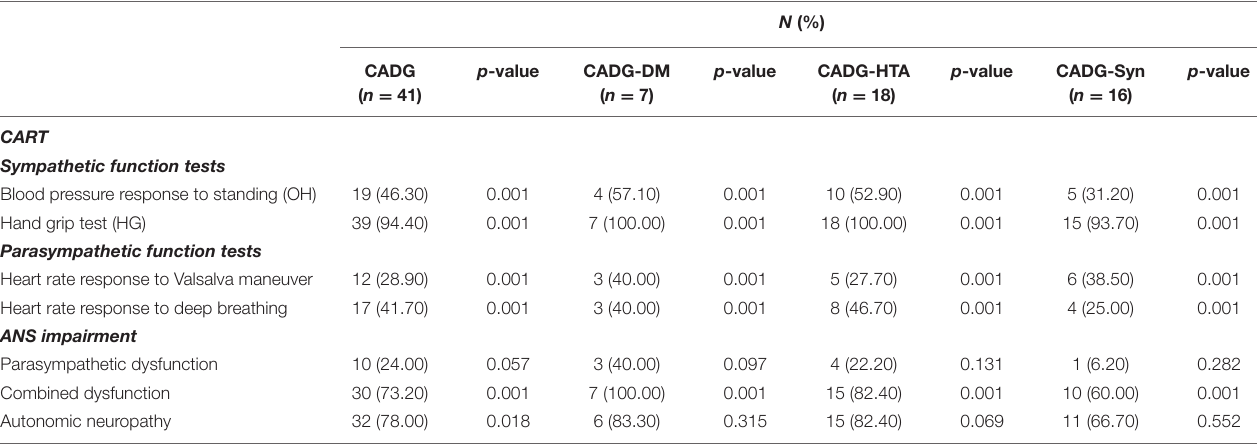
TABLE 5 | Abnormal results of cardioreflex tests in different subgroups of COVID-19 patients with associated co-morbidities.